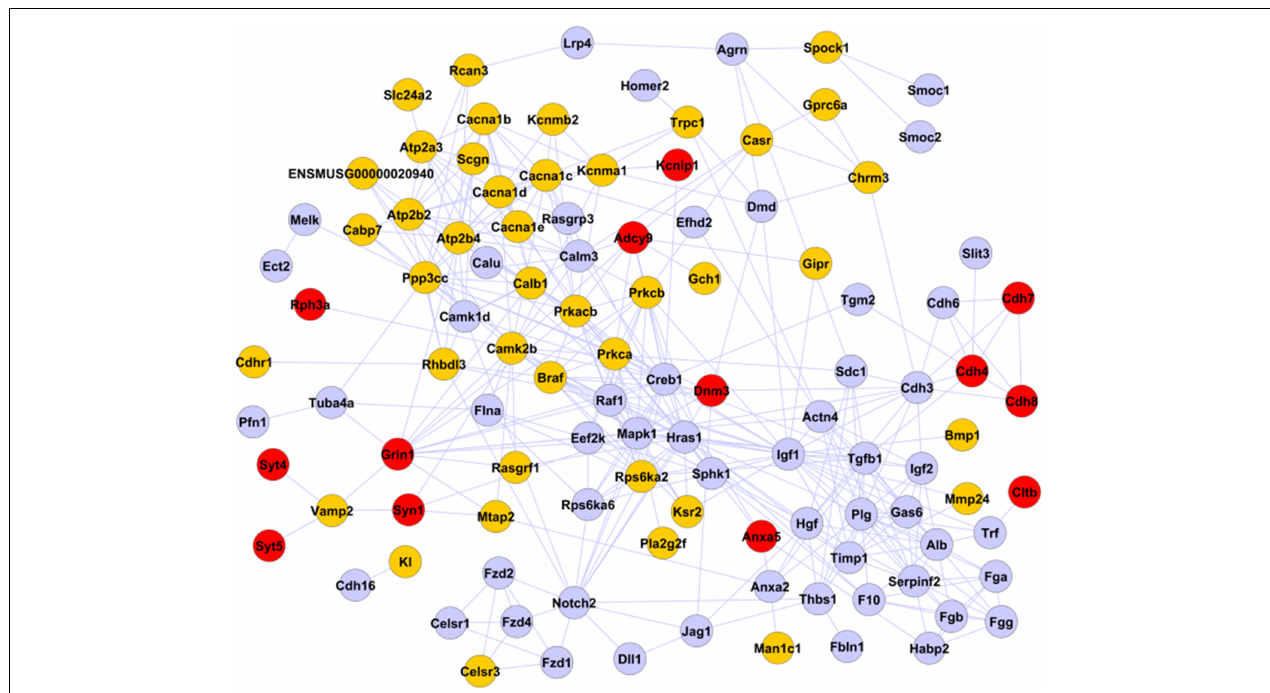
FIGURE 4 | PPI network of calcium-mediated processing. The 109 genes selected and associated with calcium-mediated processing by FunPat correspond to a PPI network of 383 interactions. Gray nodes: genes belonging to negative MPs. Yellow and red nodes: genes belonging to positive MPs. Red nodes: genes belonging to MPs with time breaks at P12 or